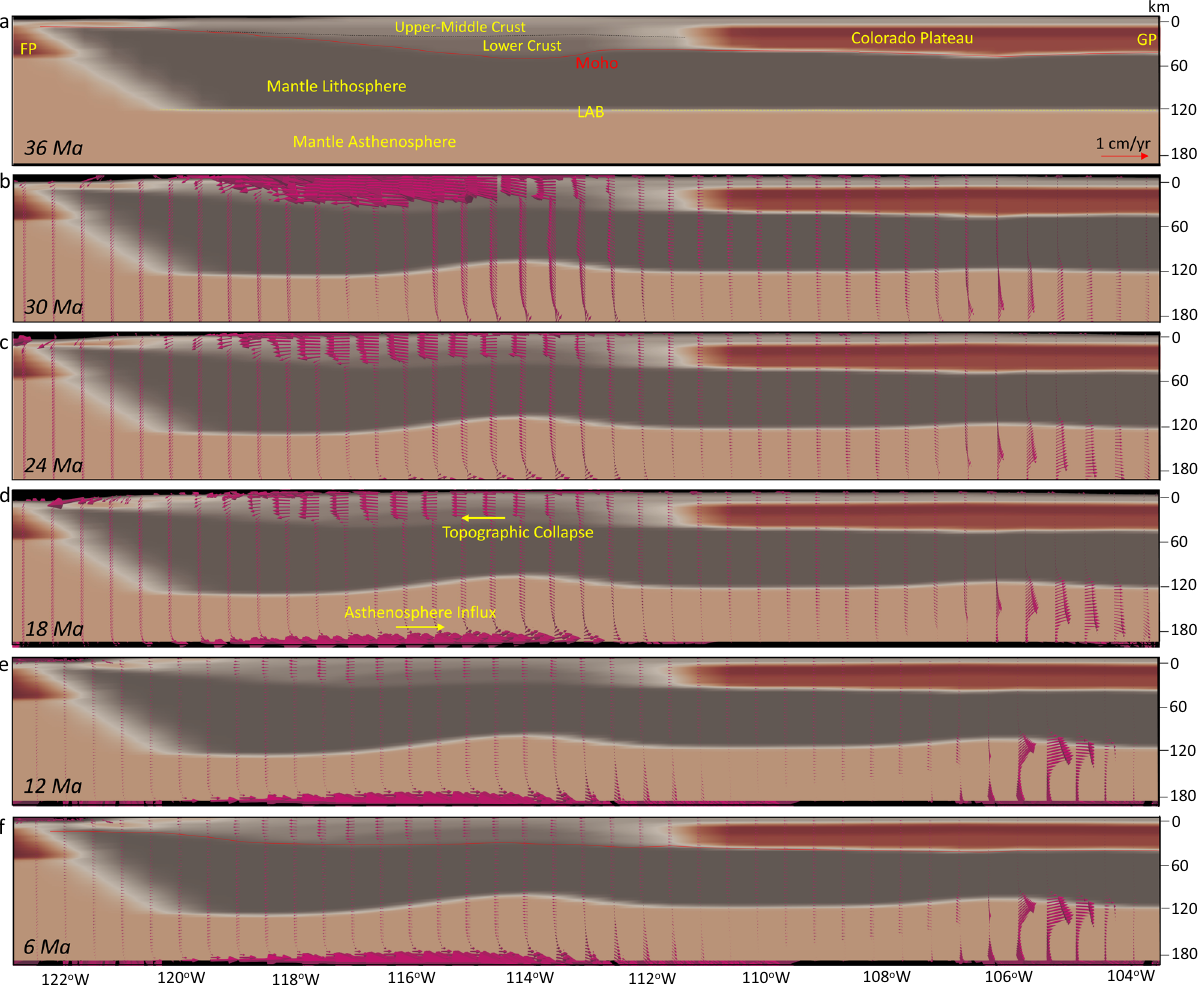
Fig. 6 Lithosphere dynamics and tectonic model achieved from 4-D thermo-mechanical model of the North American lithosphere. a – f Vertical cross- sections of the 3-D lithosphere and mantle asthenosphere at 37°N showing the evolution of a layered 3-D crust for the Basin and Range Province, Colorado Plateau, and Great Plains (GP) in southwestern North America at 36, 30, 24, 18, 12, and 6 Ma, respectively. Red vectors represent the magnitude of velocities at different depths through time. The solid red line represents the evolution of the Moho boundary, and the yellow dashed line represents the lithosphere-asthenosphere boundary (LAB) at the onset of simulation. FP: Farallon